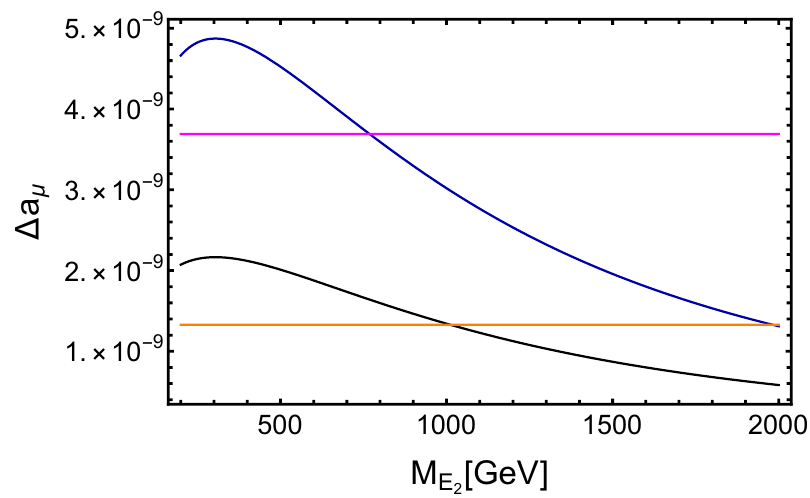
Figure 1. Muon anomalous magnetic moment as a function of the charged exotic lepton mass M The black and blue curves correspond to y E = y E 2 = 0 . 2 and y E = y E 2 = 0 . 3 , respectively. The horizontal magenta and orange lines correspond to the 2 σ upper and lower bounds for the muon anomalous magnetic moment,